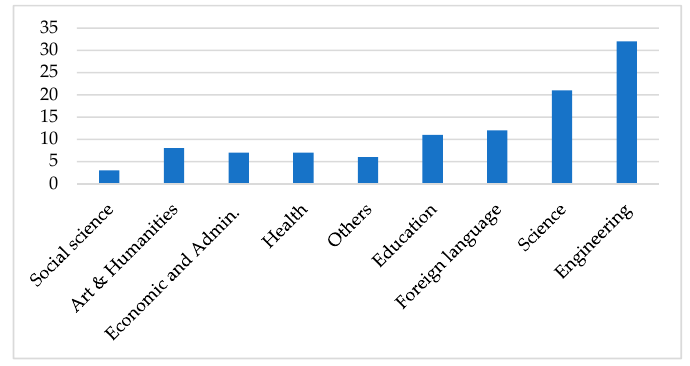
Figure 7. Number of documents categorized by field of knowledge.